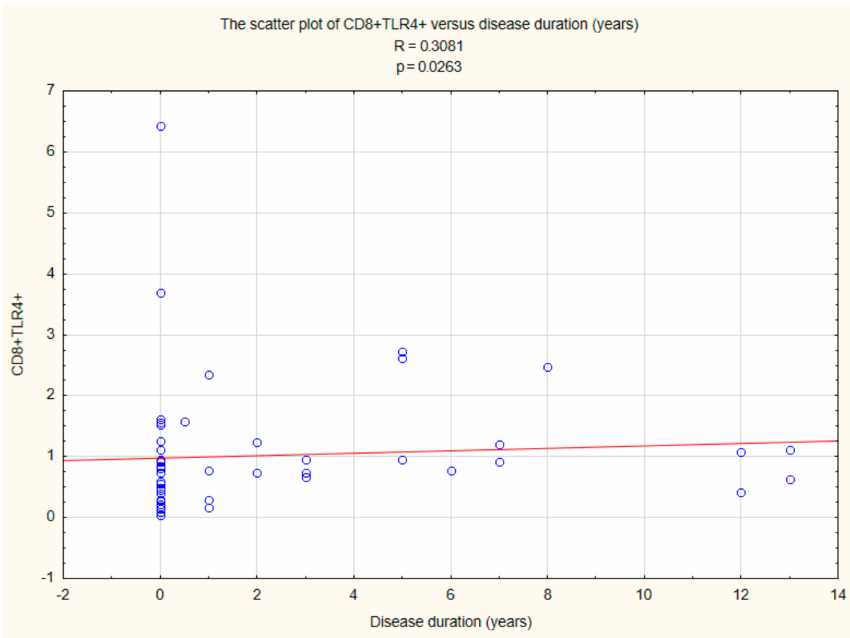
Figure 8. Relationship between CD8+ TLR4+ T cells and duration time after the onset of DM1. Statistically significant relationships were also found between CD8+ TLR9+ T cells (R = 0.2827, p < 0.05) and duration time after the onset of DM1 (Figure 9).